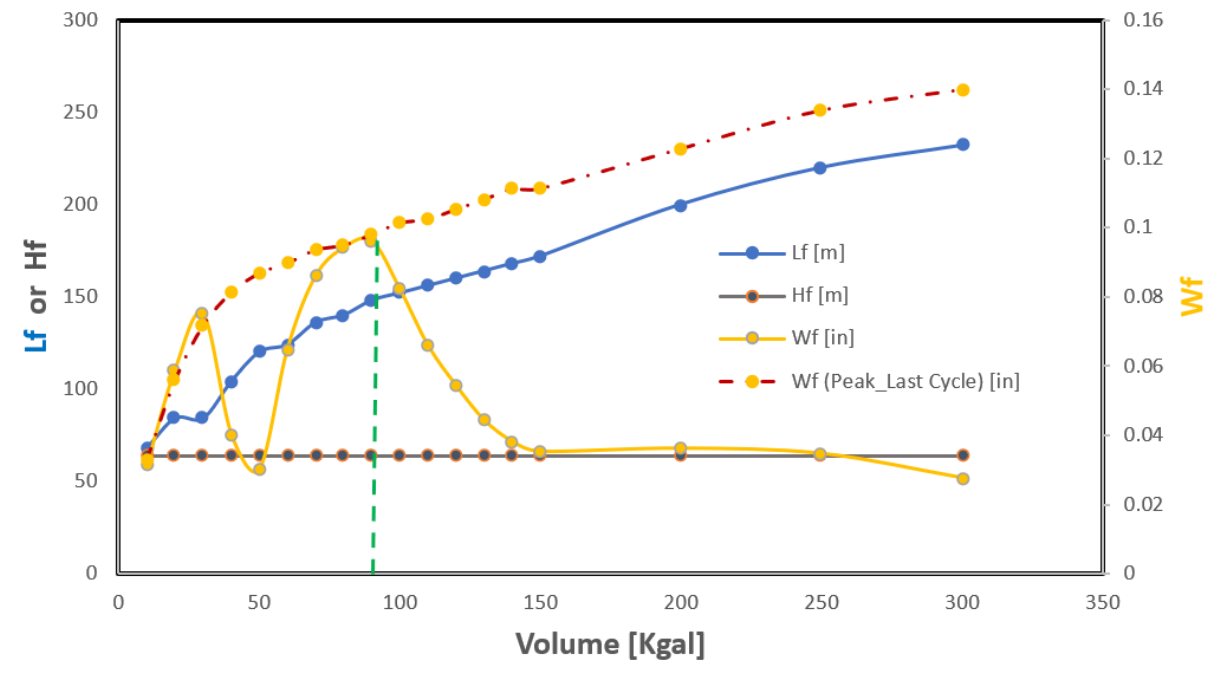
Figure 9. Finding optimized injection volume of 90 k-gal at the optimum injection rate of 18 BPM and with three stages of acid batches.